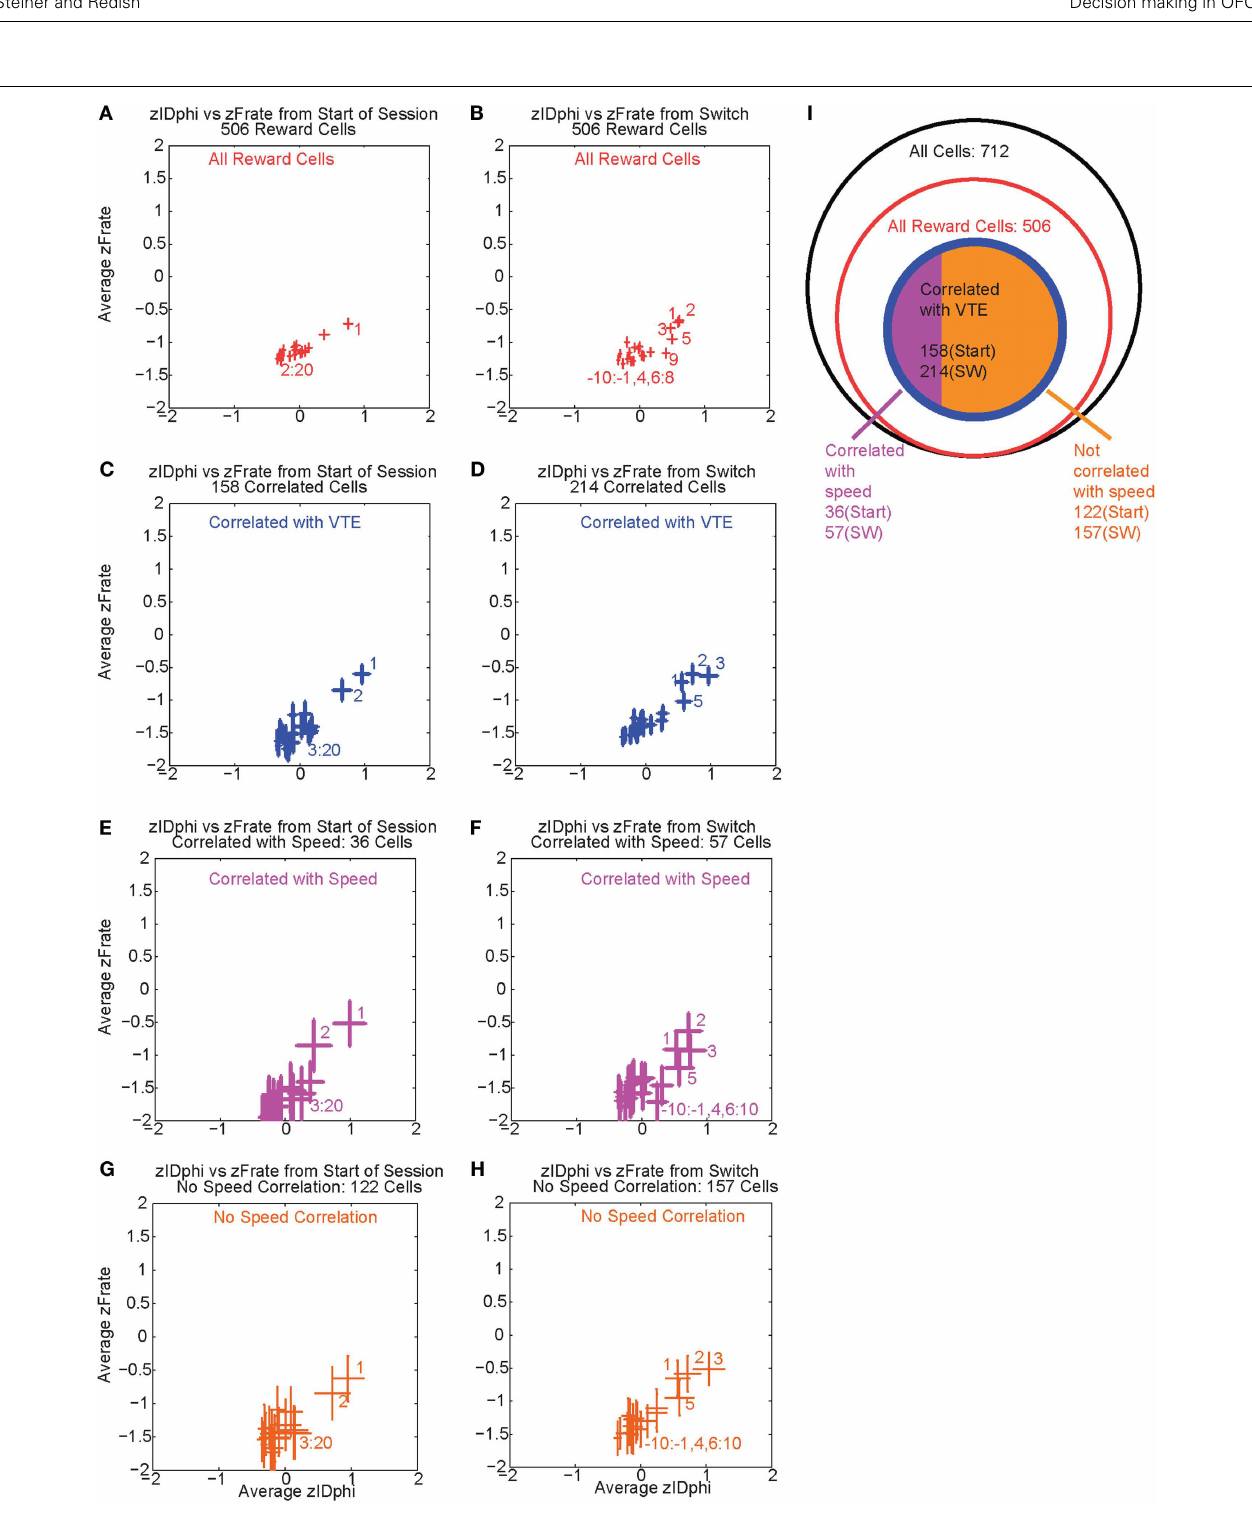
reward contingency. For many of these cells, so much activity was present at the reward site relative to the rest of the maze, that the zFiring rate was negative at all locations, even at the choice point, even when the cell fired extra spikes at the choice point and not elsewhere.The shift in z -scores during VTE identified that reward responsive cells increased their firing rate, but not to the same level as seen at the reward locations.The top panels (A,B) shows